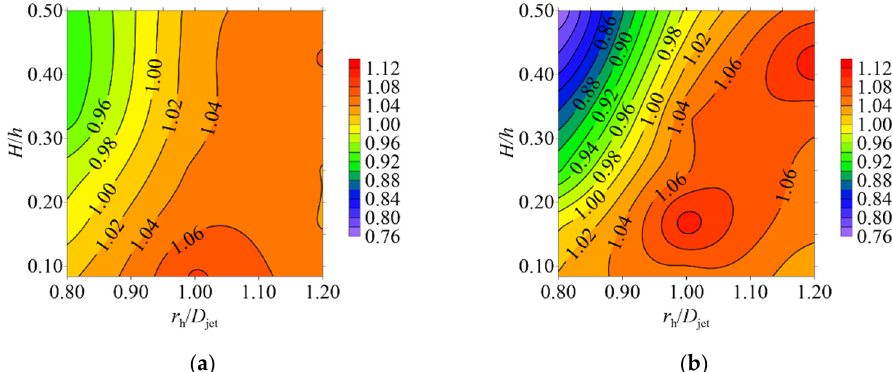
Figure 17. Contour maps of the global maximum horizontal velocity: ( a ) L = 0.5 D jet ; ( b ) L = 1.0 D jet .